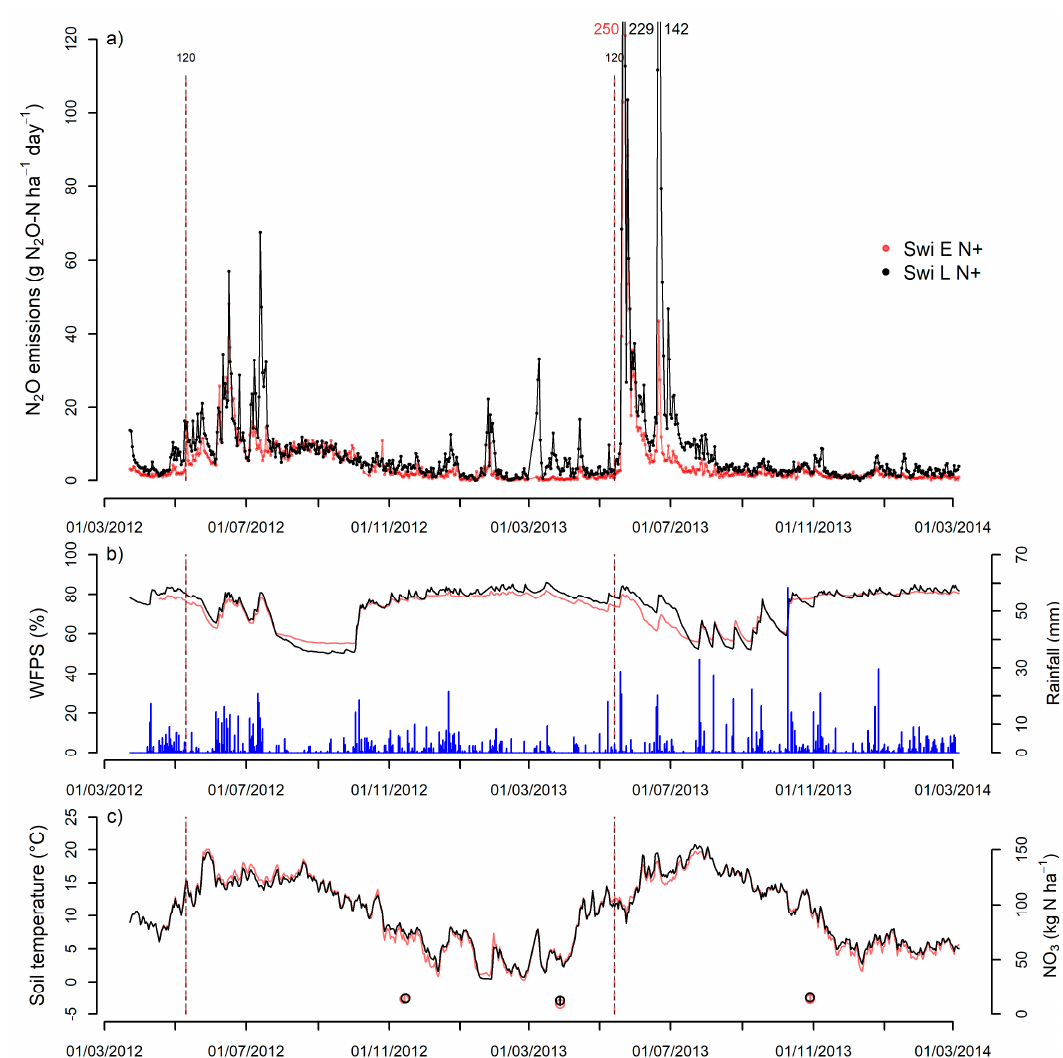
Figure 3. Daily N 2 O emissions ( a ); daily rainfall and WFPS (0–30 cm) ( b ); and daily soil temperature (15 cm) and soil nitrate content (0–30 cm) ( c ) under switchgrass: Swi E N + (green) and Swi L N + (red). Each point in ( a ) represents a measured value (daily average). Vertical dotted lines represent fertilization events with the N rate in kg N ha − 1 . Vertical lines in ( c ) represent the standard deviations for soil nitrate content. Five daily N 2 O fluxes were higher than 120 g N 2 O-N ha − 1 day − 1 and do not appear in ( a ). For Swi E N + : 250 g N 2 O-N ha − 1 day − 1 on 22 / 05 / 2013. For Swi L N + : 139, 229, 166 and 142 g N 2 O-N ha − 1 day − 1 on 21 / 05 / 2013, 22 / 05 / 2013, 21 / 06 / 2013 and 22 / 06 / 2013, respectively. See Table 1 for treatment abbreviations.